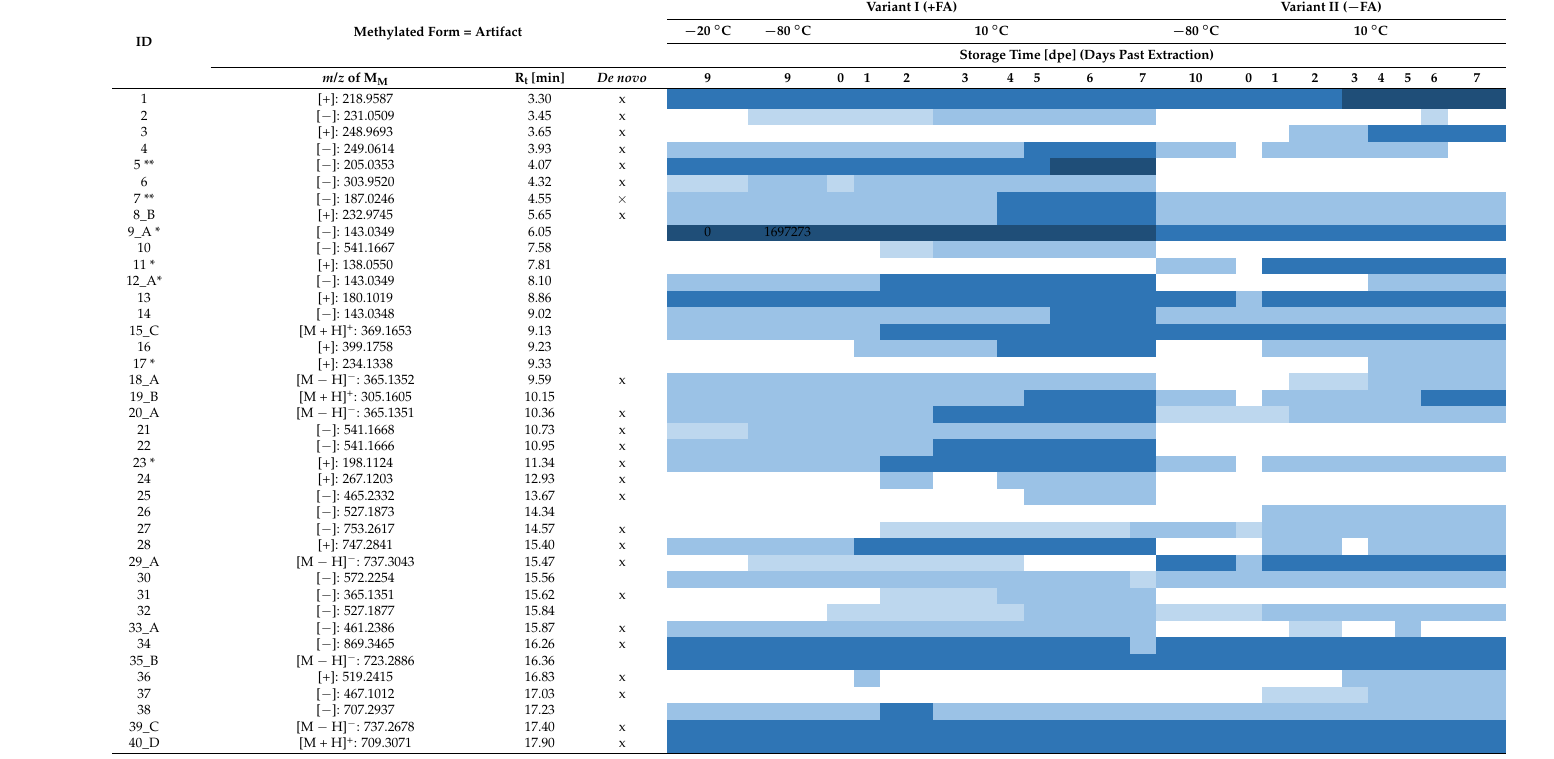
Table 1. Overview of all detected artifacts, illustrated by the most abundant feature per artifact compound. The complete table with all detected artifact features and additional information is provided in Table S1 (supplementary material). Mean peak areas ( n = 5 replicates) of respective artifacts are shown in a logarithmically scaled color code. For calculation of mean peak area per artifact the respective metabolite compound ions had to be present in at least 4/5 replicates. If more than one ion was detected for an artifact, features belonging to the same artifact metabolite are indicated with _A, _B, . . . ; **: identified by experimental methylation of the authentic reference standard with a mixture of native and deuterated methanol. *: substance class is probably known (for detailed information see Table